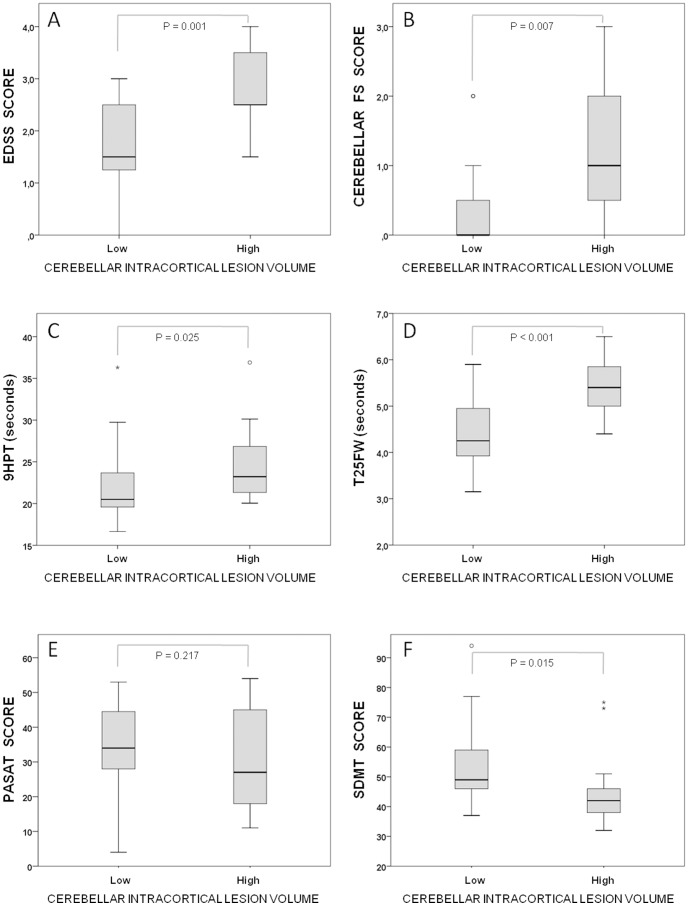
Burden of cerebellar intracortical lesions and clinical/cognitive outcomes.Box plots comparing patients with high and low burden (> 0.05 cm3 or<0.05 cm3) of cerebellar intracortical lesions on clinical (A – D) and cognitive outcomes (E, F).